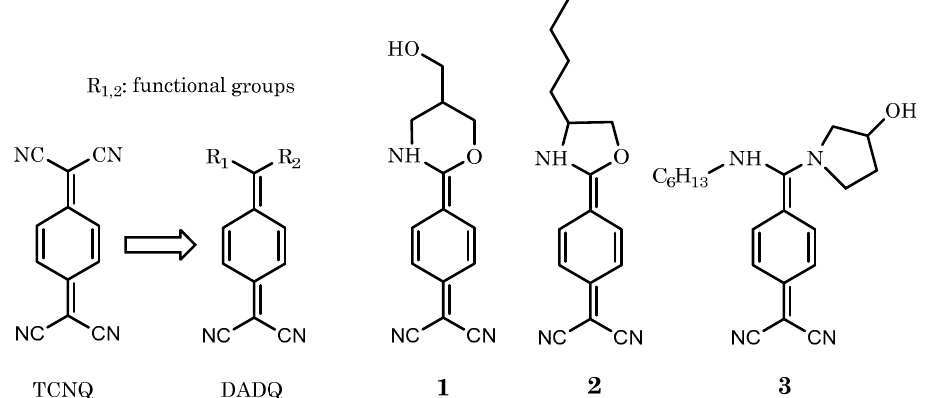
Figure 1. Left, chemical structure of un-functionalized TCNQ. The insertion of functional groups R 1 (and R 2 ) leads to the formation DADQs. To the right, the three DADQs used in this study. ( 1 ) (2-(4- (5-(hydroxymethyl)-1,3-oxazinan-2-ylidene) cyclohexa-2,5dien-1-ylidene)malononitrile), ( 2 ) (2-(4-(4- butyloxazolidin-2-ylidene)cyclohexa-2,5-dien-1ylidene)malononitrile) and ( 3 ) (2-(4-((hexylamino)(3- hydroxypyrrolidin-1-yl)methylene)cyclohexa2,5-dien-1-ylidene)malononitrile). See text for detail.